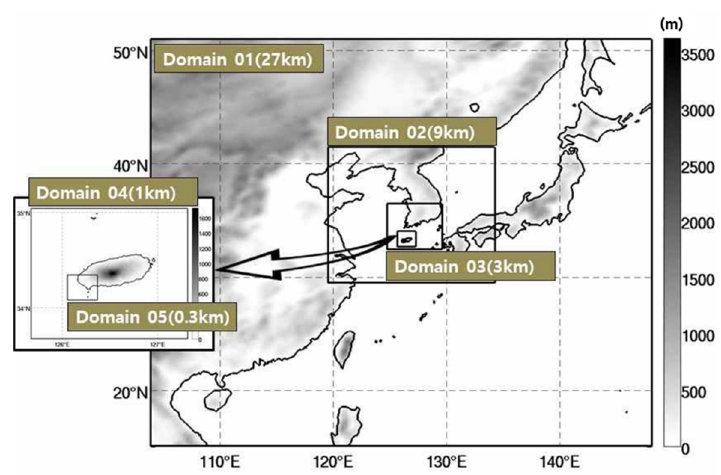
Figure 2. Configuration of the two-way nested domains of the weather research forecasting (WRF) model. Sizes of the domains (from left to right) are 27 km, 9 km, 3 km, 1 km and 0.3 km. Darkness represents the topography. Table 2. WRF physics schemes used in this study.